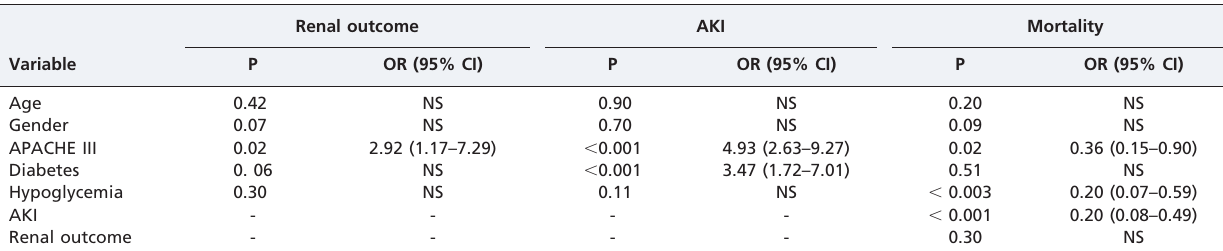
Table 5 - Multivariate logistic